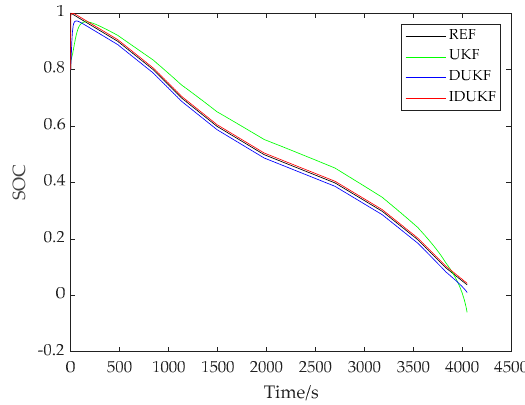
Figure 17. SOC estimation in the VCCC tests.